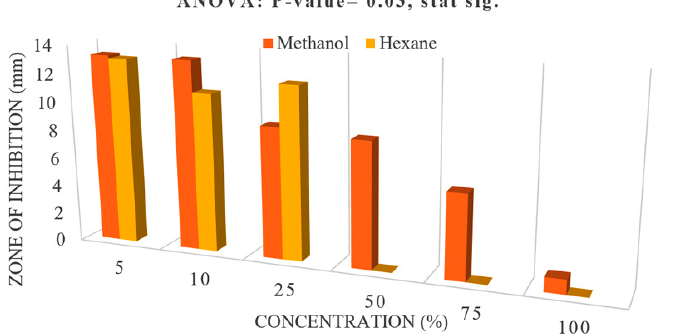
Fig. 3. Difference in zone of inhibition at different conc. for methanol and hexane extract of C. cinereum